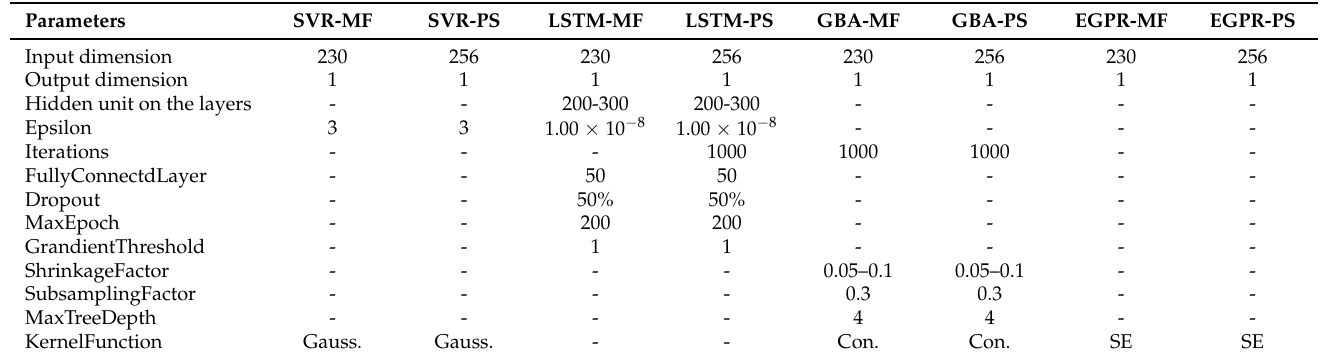
Table 1. Summarized parameters of the proposed EGPR with hybrid features based on PPG signals, where Con. denoted a convolution kernel for the GBA method, SE was a squared exponential kernel for the EGPR algorithm.